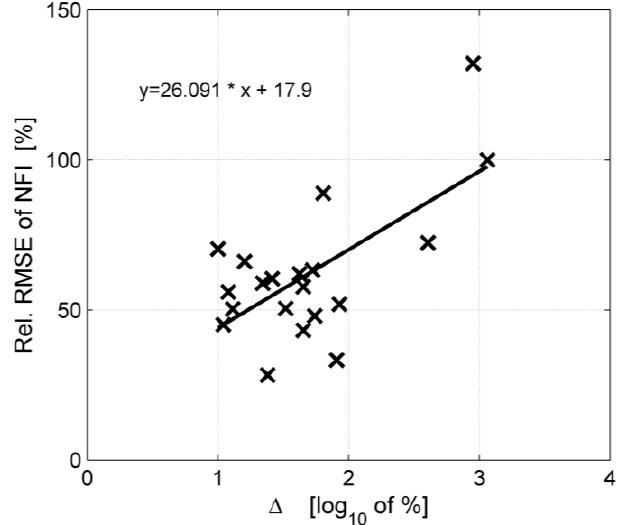
Figure 7. Scatter plot of relative root mean square error (RMSE) of Swedish National Forest Inventory (NFI) estimates of clear-felled areas (Table 5) with respect to the relative difference between PALSAR and NFI statistics according to Equation